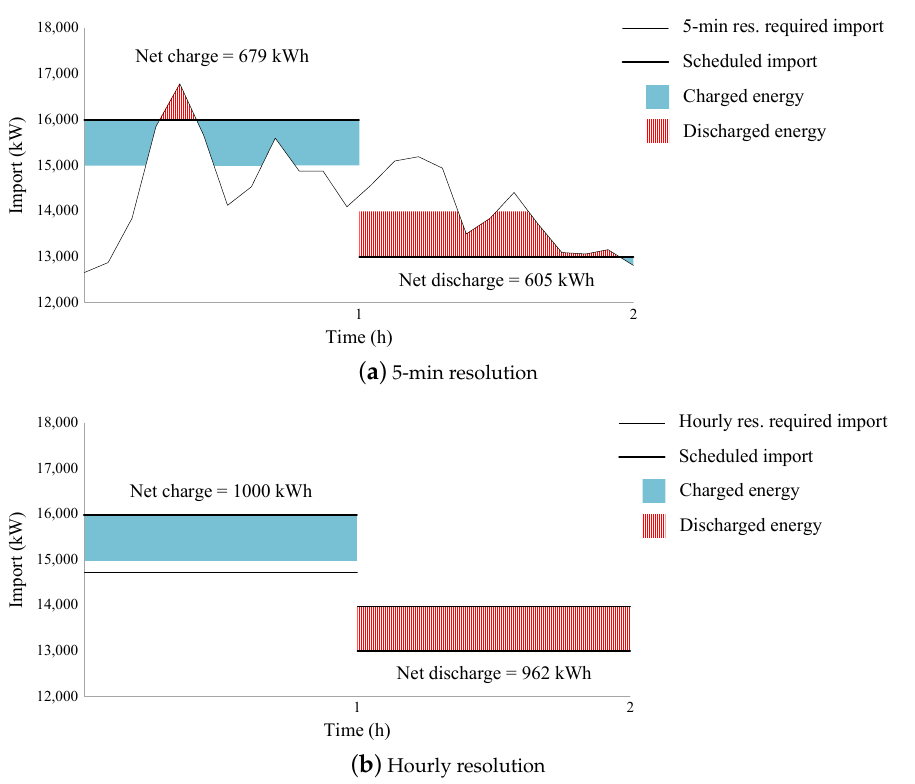
Figure 13. 5-min and hourly resolution of Summerside Electric actual required power import for a sample 2-h period.